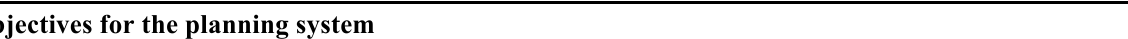
Table 2. The planning system with focus on sustainable development, in Planning Policy Statement 1 (PPS1) [11].